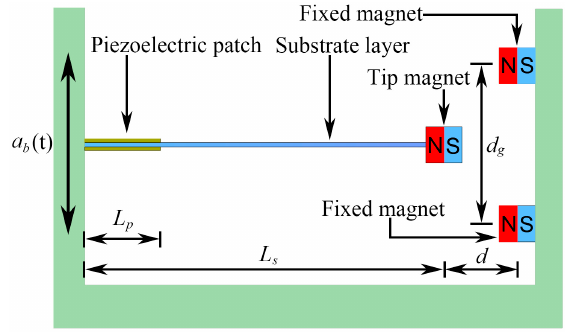
Figure 1. Schematic diagram of MPEH.